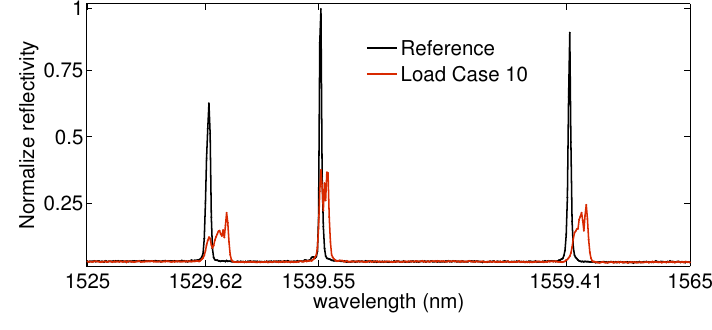
Figure 10. Normalized reflectivity of fiber Bragg grating 1 (FBG1) (1529.62 nm), FBG2 (1539.55 nm) and FBG3 (1559.41 nm) for two different transverse load conditions. Spectral distortion occurs when the load increases from the reference condition (black curve) to Load Case 10 (red curve).